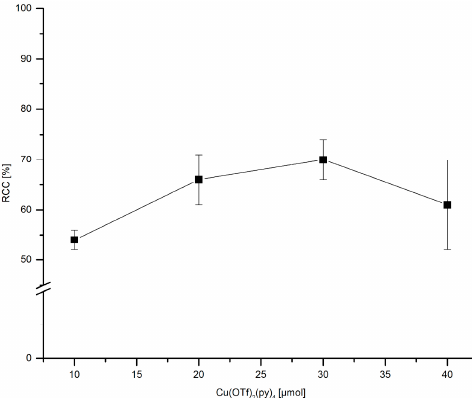
Figure 10. Dependency of Cu(py) 4 (OTf) 2 amount on RCC. Conditions: [ 18 F]Fluoride (~50 MBq) was eluted from a QMA-CO 3 cartridge with a solution of Et 4 NOTf (3.1 mg, 11 µmol) in n BuOH (300 µL)